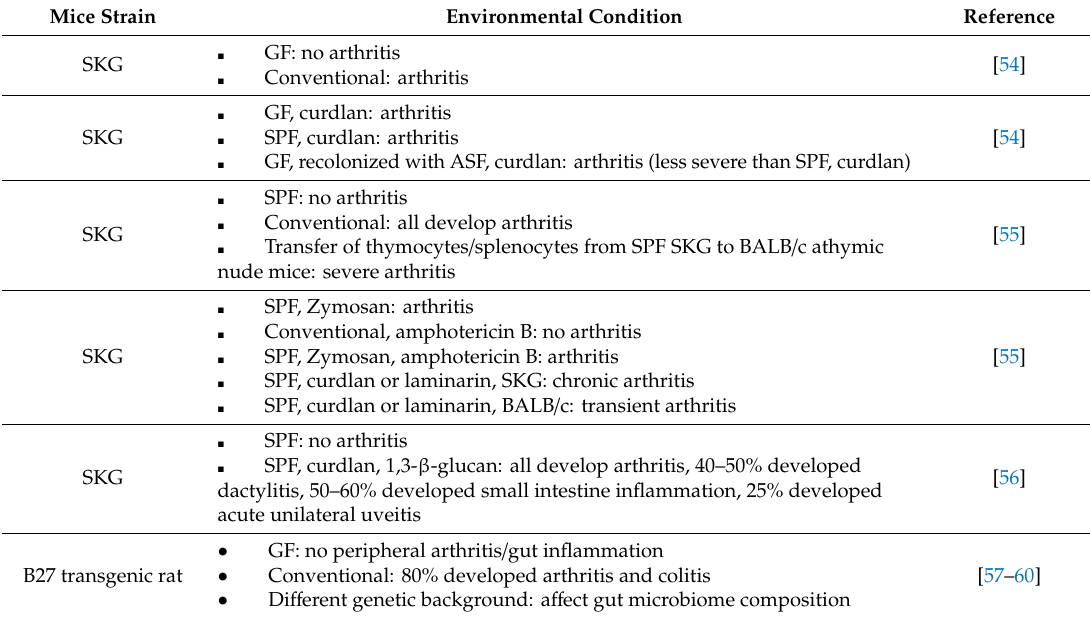
Table 1. Murine Models of SpA Associated with